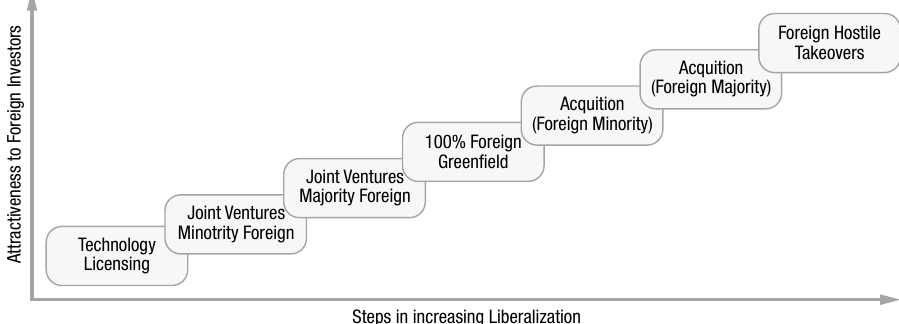
Fig. 1. Increasing Government Allowance of Foreign Equity Participation ( Source: Stoever